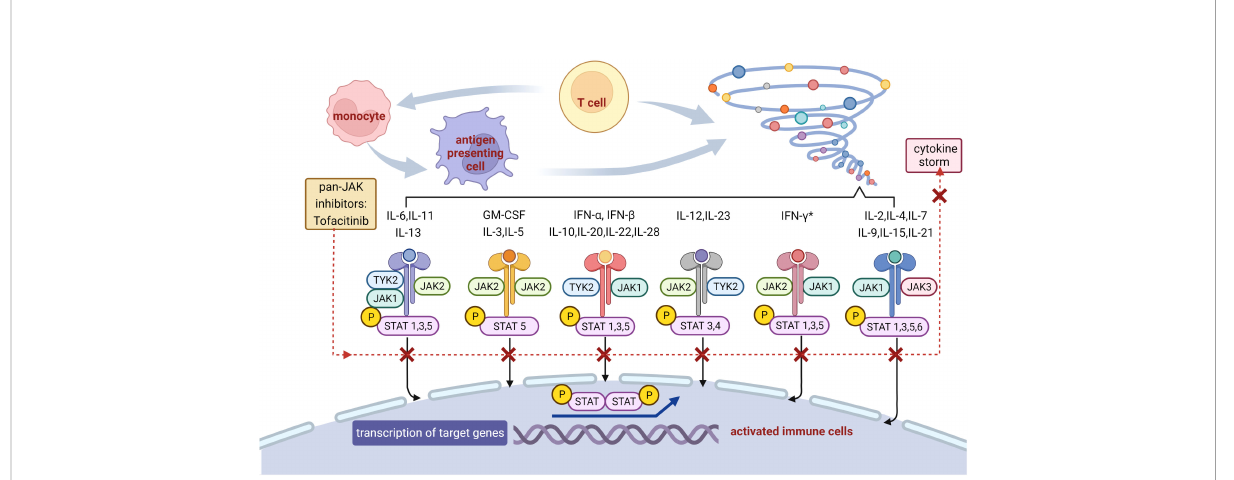
FIGURE 2 Potential mechanism of the blockade on in fl ammatory storm with tofacitinib. JAKs phosphorylate tyrosine residues on their cytokine receptors, leading to recruitment and phosphorylation of STATs. Phosphorylated STATs dimerize and translocate to the nucleus, where they promote the transcription of genes encoding proteins with functions in proliferation and in fl ammation. Tofacitinib binds to JAKs thus prevents downstream gene transcription, resulting in reduction in cytokine storm and in fl ammatory cascade. * Tofacitinib has showed ef fi cacy for immune-related colitis, probably through the inhibition of IFN- g signaling. JAK, Janus kinase; STAT, signal transducer and activator of transcription; P, phosphorylation; TYK, tyrosine kinase; IL, interleukin; GM-CSF, granulocyte macrophage colony stimulating factor; IFN,